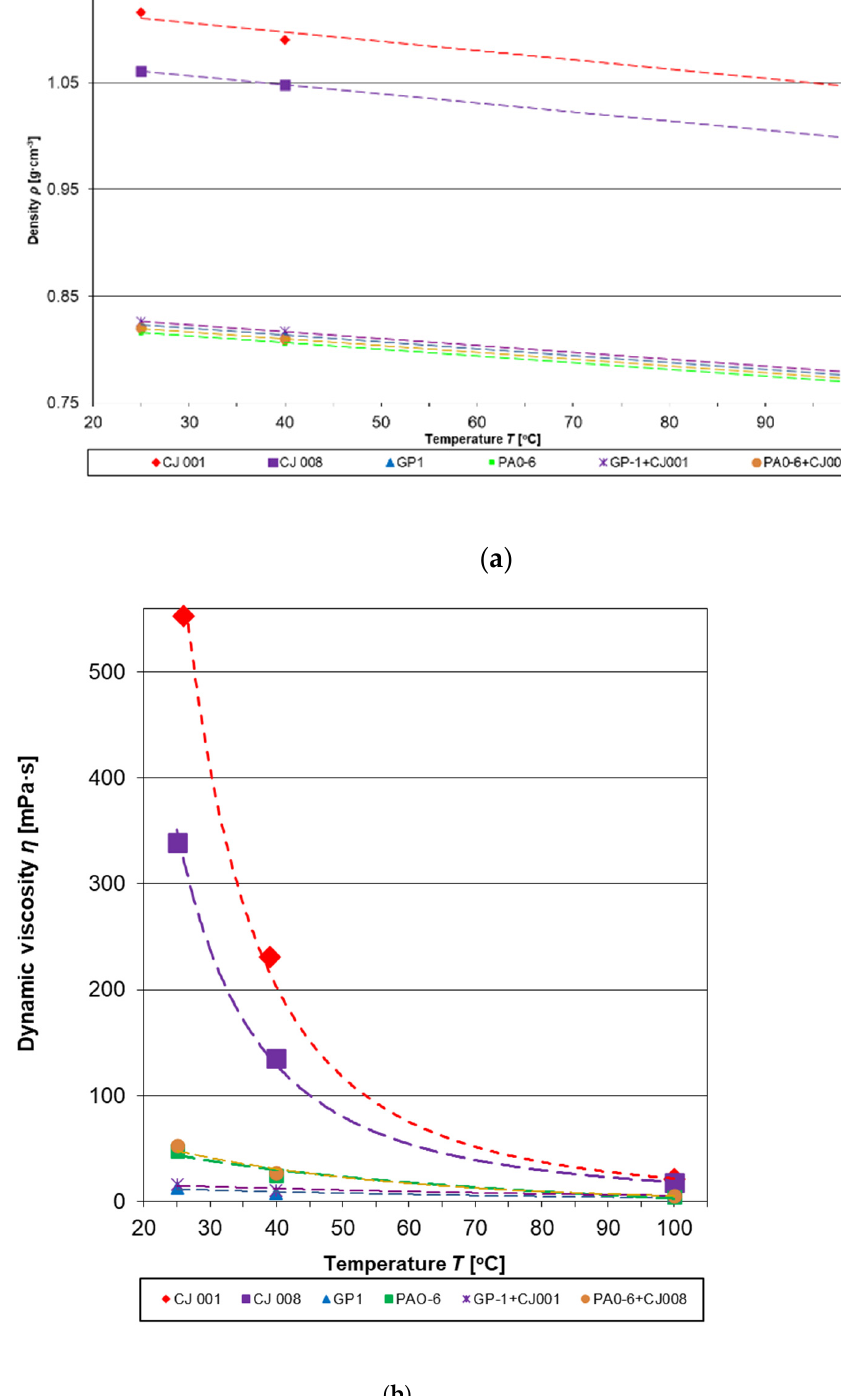
Figure 3. Dependence of the density ( a ) and viscosity ( b ) of base oils, ionic liquids, and their mixtures on temperature.